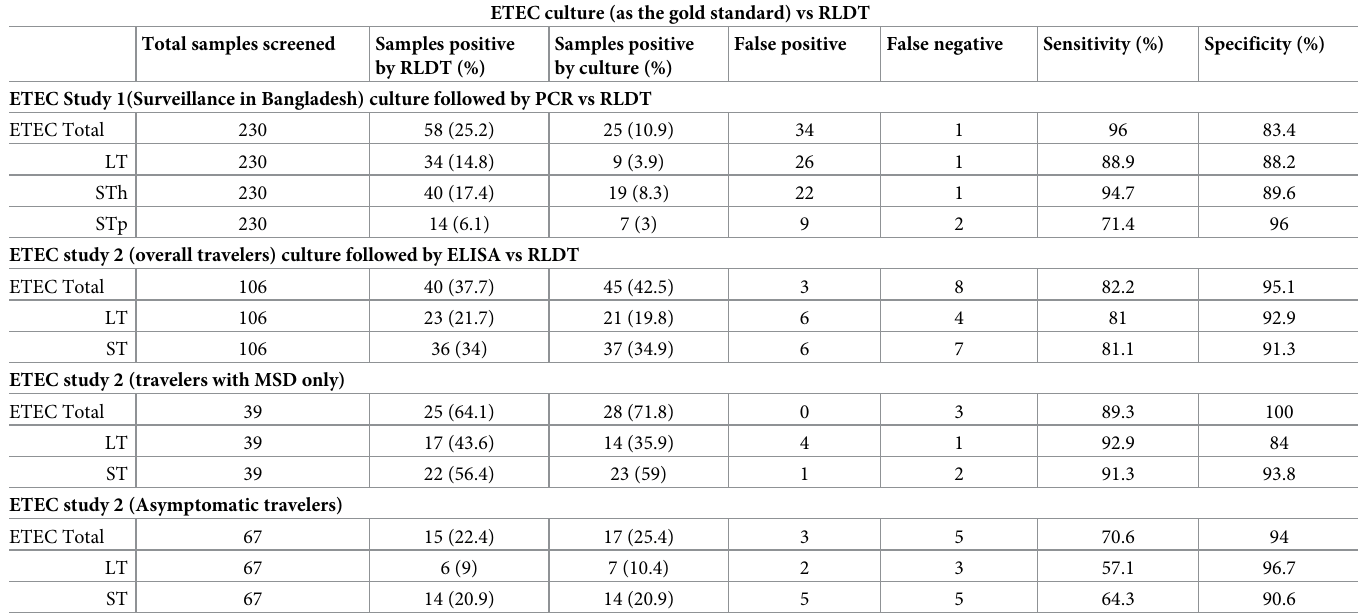
Table 3. Sensitivity and specificity of ETEC RLDT compared to